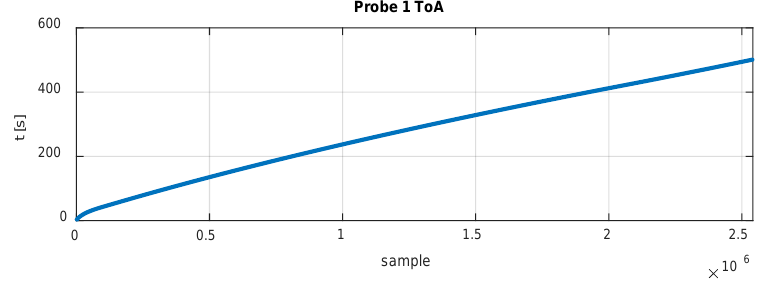
Figure 6. ToA of the probe 1 for the BTT system of the Surveillance 9 contest (see Section 3).